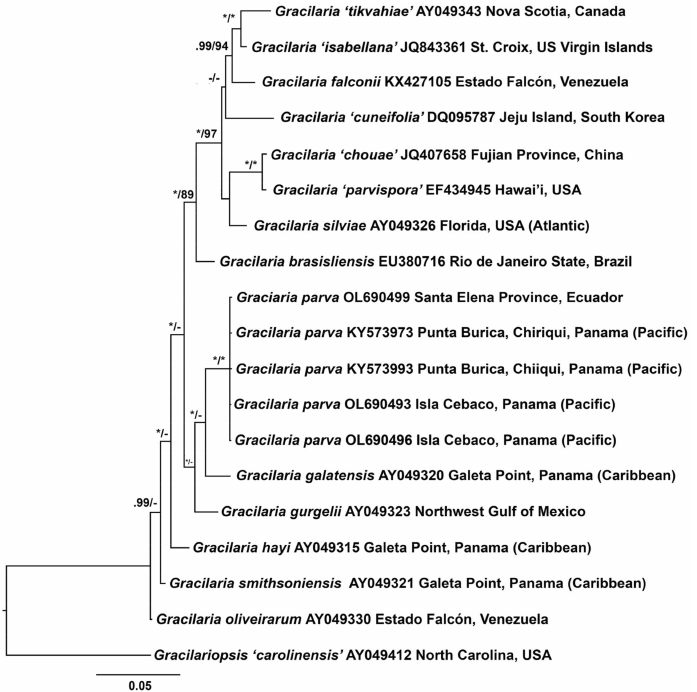
Figure 1. Bayesian phylogram of rbc L sequences showing placement of Gracilaria parva in a clade with tropical western Atlantic species. The species of Gracilaria in single quotation marks (‘ ’) have not had their type specimens sequenced. Support values at phylogram nodes are posterior probabilities (PP) followed by bootstrap percentages (BP): * at nodes indicate full support; - at nodes indicate support values below 0.8 PP and 80% BP that are not